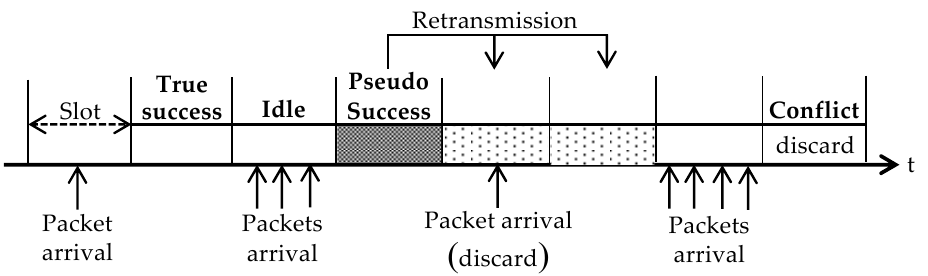
Figure 1. Novel frameless slotted ‐ ALOHA protocol.